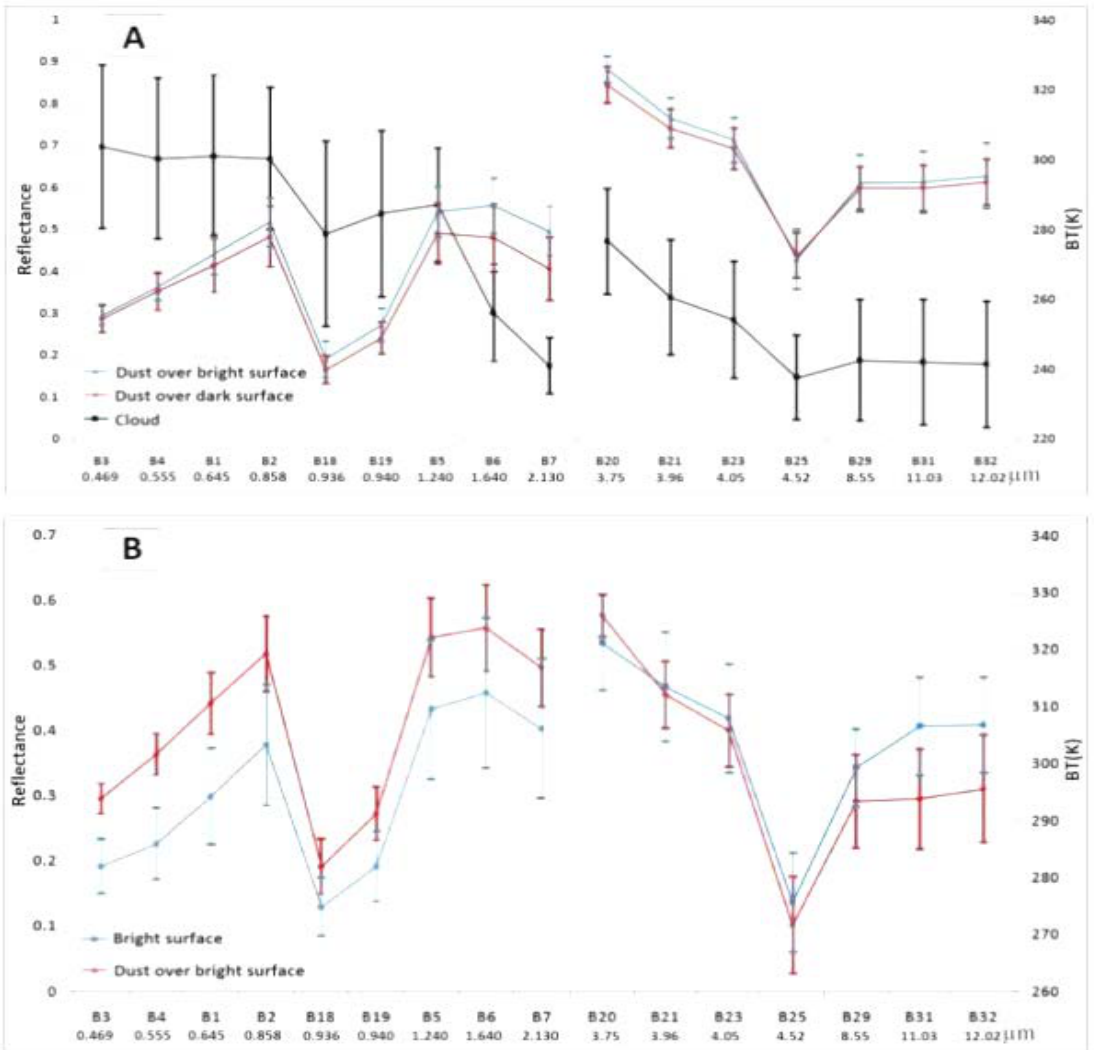
Fig .3: A repersenting the curves of spectral for f dust on a bright surface, in optical and thermal bands are showing the dust on a dark surface and cloud,(B) illustrating the curves of spectral for a bright surface and dust on a dark surface ,( Response curves of dust and cloud (left y-axis corresponds to B8, B3, B4, B1, B2, and B7; right y-axis corresponds to B20, B29, B31, and B32). Red line: the reflectance/bright temperature of the cloud)